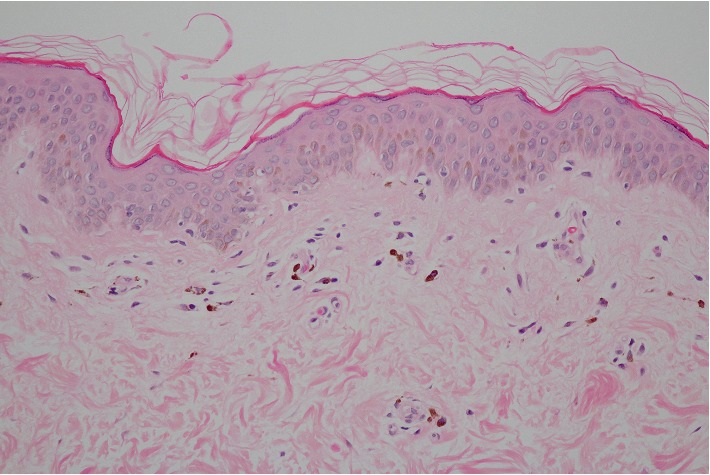
Histopathology of AD patient showing a normal epidermis, focal basal vacuolization along the DEJ, sparse superficial perivascular lymphocytic infiltration, and mild melanophage deposition (hematoxylin-eosin stain, original magnification ×100).